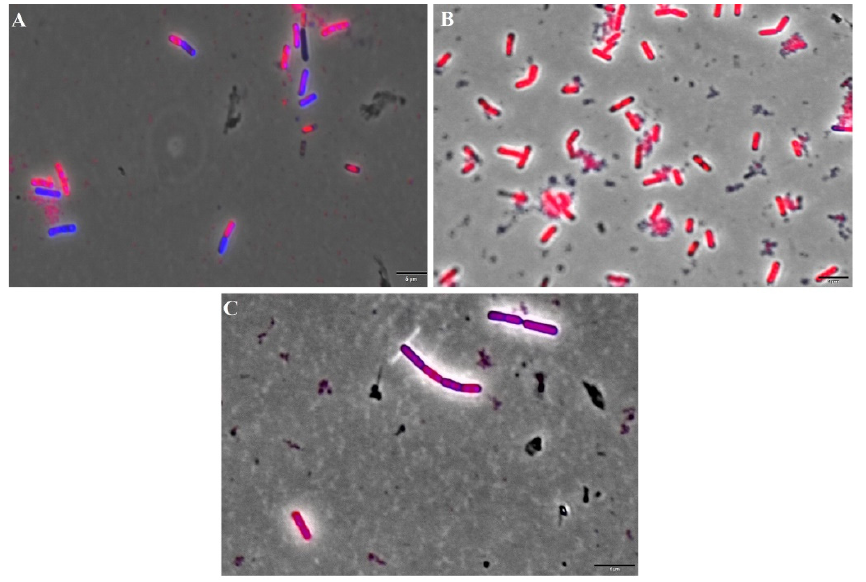
Figure 4. Fluorescence microscopy of Bacillus subtilis stained with propidium iodide and SYTO9. ( A ) negative control (cells treated with 1% DMSO); ( B ) positive control (cells treated with nisin at 5.0 µg/mL). ( C ) cells treated with IBC . Magnification 100×; Scale bar 5 µm.